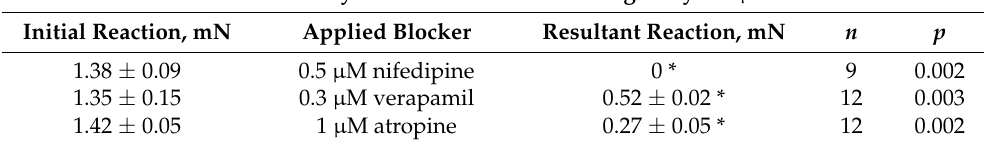
Table 3. Changes in the tonic activity of the SMPs incubated with water extract of the fruiting body at 100 µ M concentration after application of Ca 2+ channel blockers, * p < 0.05. Tonic Activity of Water Extract of Fruiting Body 100 µ M Initial Reaction, mN Applied Blocker Resultant Reaction, mN n p 1.38 ± 0.09 0.5 µ M nifedipine 0 * 9 0.002 1.35 ± 0.15 0.3 µ M verapamil 0.52 ± 0.02 * 12 0.003 1.42 ±